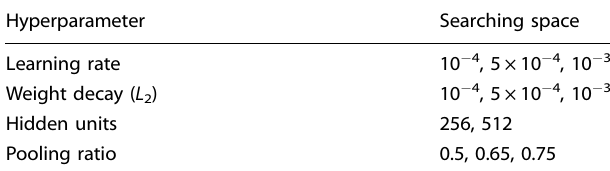
Table 4. Search space for hyperparameters of GNN